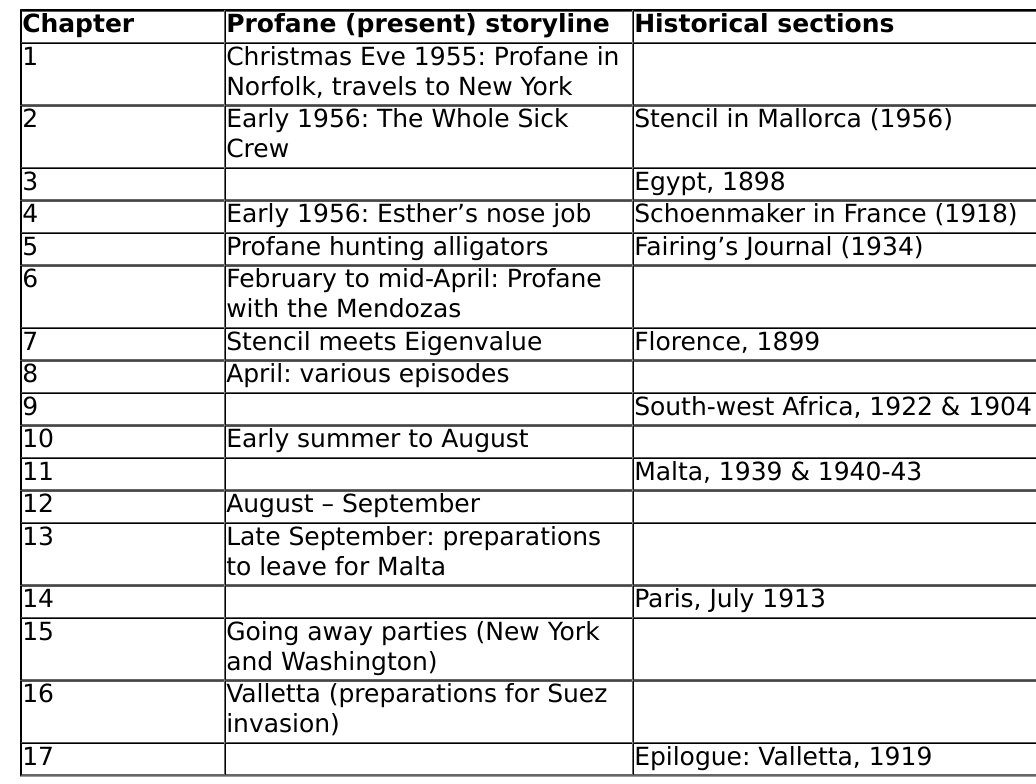
Table 1: The exact distribution of present and historical episodes per chapter (adapted from Seed, pp.